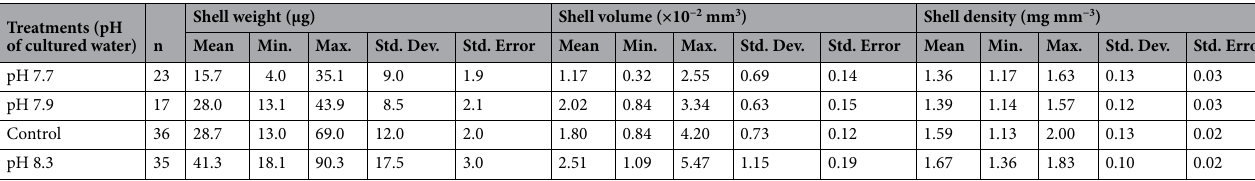
Table 1. Shell weight, volume, and density of cultured Amphisorus kudakajimensis under four different pH